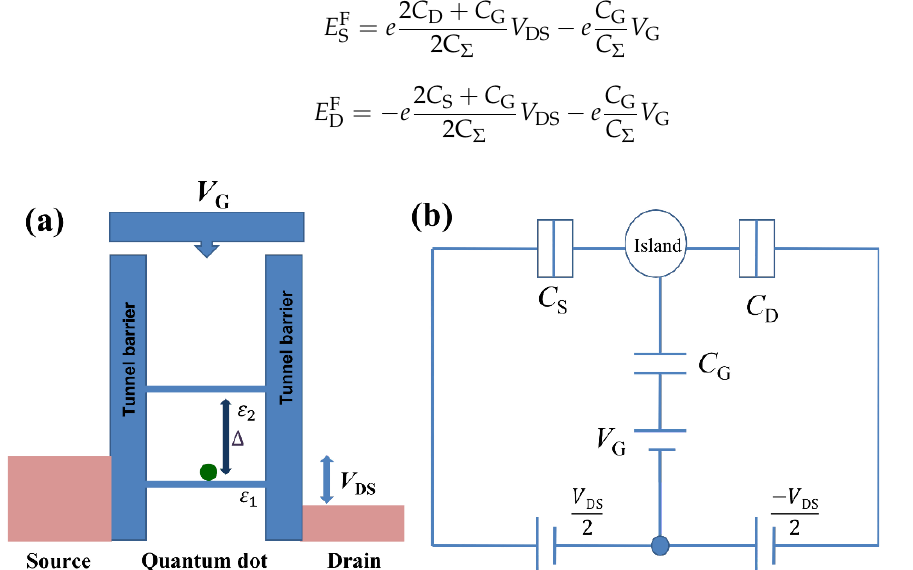
Figure 2. ( a ) Schematic potential diagram of a double-barrier QD system with the tunnel barriers also controlled by the gate voltage. ( b ) Equivalent electrical circuit model of a QD in the double-barrier configuration with symmetric bias.